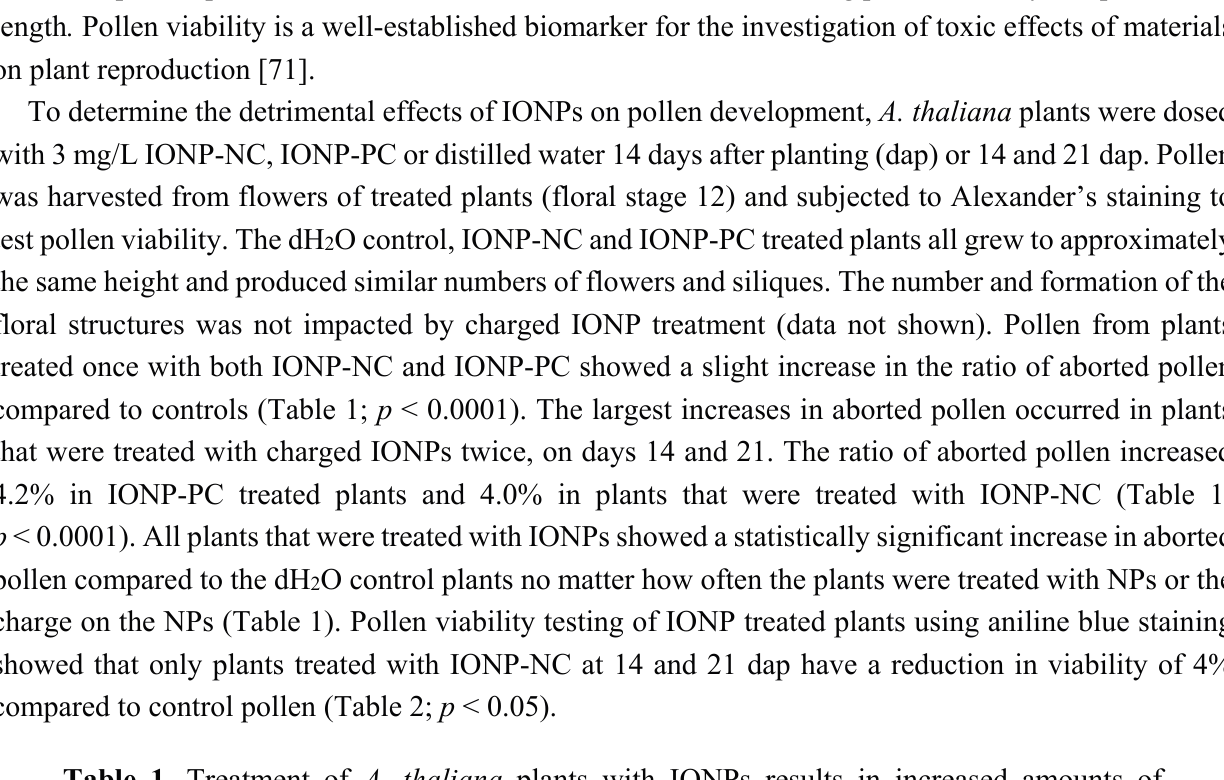
Table 1. Treatment of A. thaliana plants with IONPs results in increased amounts of aborted